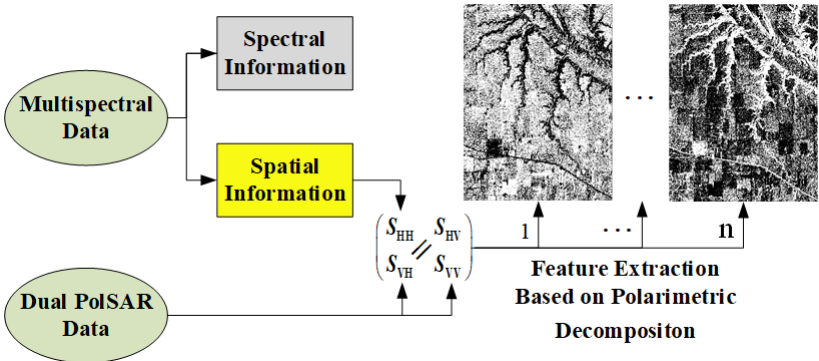
Figure 1. Illustration of the polarization extension